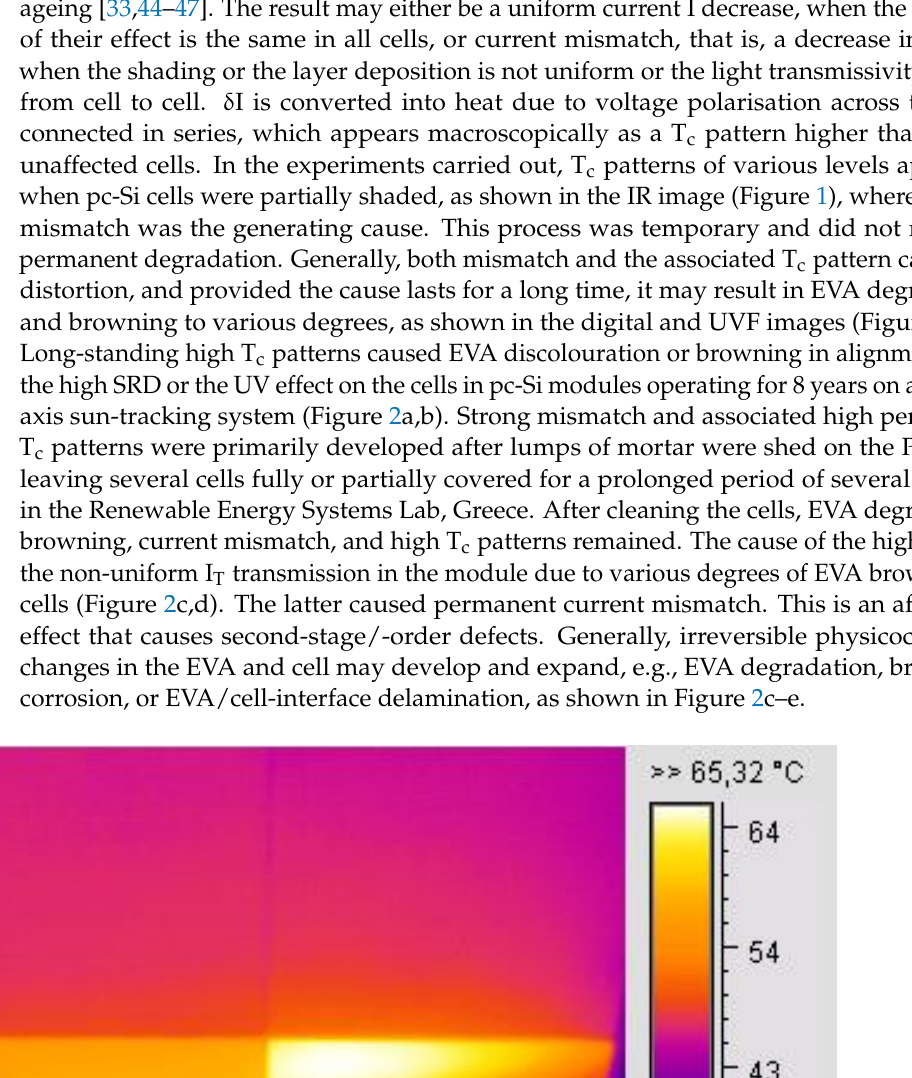
patterns in the c